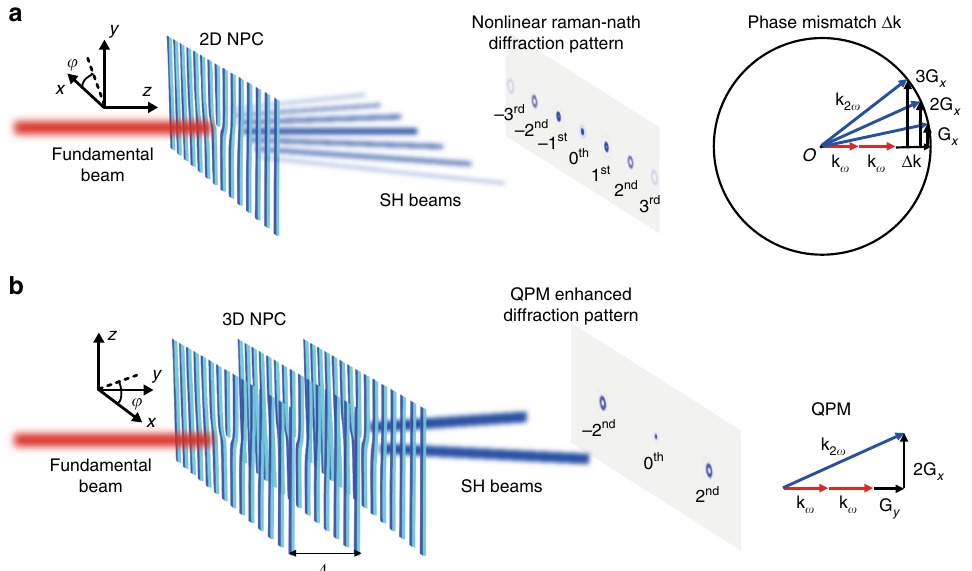
Fig. 1 Design principle of 3D NPCs. a Nonlinear Raman-Nath diffraction orders are generated when a fundamental beam is incident on a 2D nonlinear fork- grating NPC. The SH diffraction pattern exhibits multiple vortex beams with intensity reducing from low to high diffraction orders. However, there exist momentum mismatches Δ k in the propagation directions for various diffraction orders in nonlinear Raman-Nath diffraction. b A 3D nonlinear fork-grating array provides the needed reciprocal vector to compensate momentum mismatch in the propagation direction, so that the selected diffraction orders of SH beams are greatly enhanced. Here, the ±2nd orders are depicted for example. In our experiment, Λ y = 3 μ m. NPC, nonlinear photonic crystal; SH, second- harmonic; QPM, quasi-phase-matching, 2D, two-dimensional; 3D,